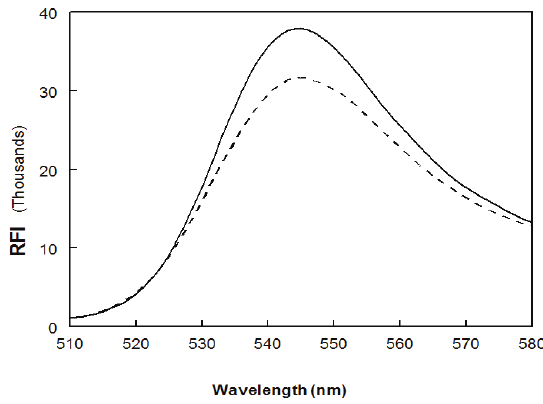
Figure 1: Emission spectra of eosin Y (―) and its reaction product with 2 µg mL -1 nebivolol hydrochloride (- - -) after excitation at 302 nm at pH